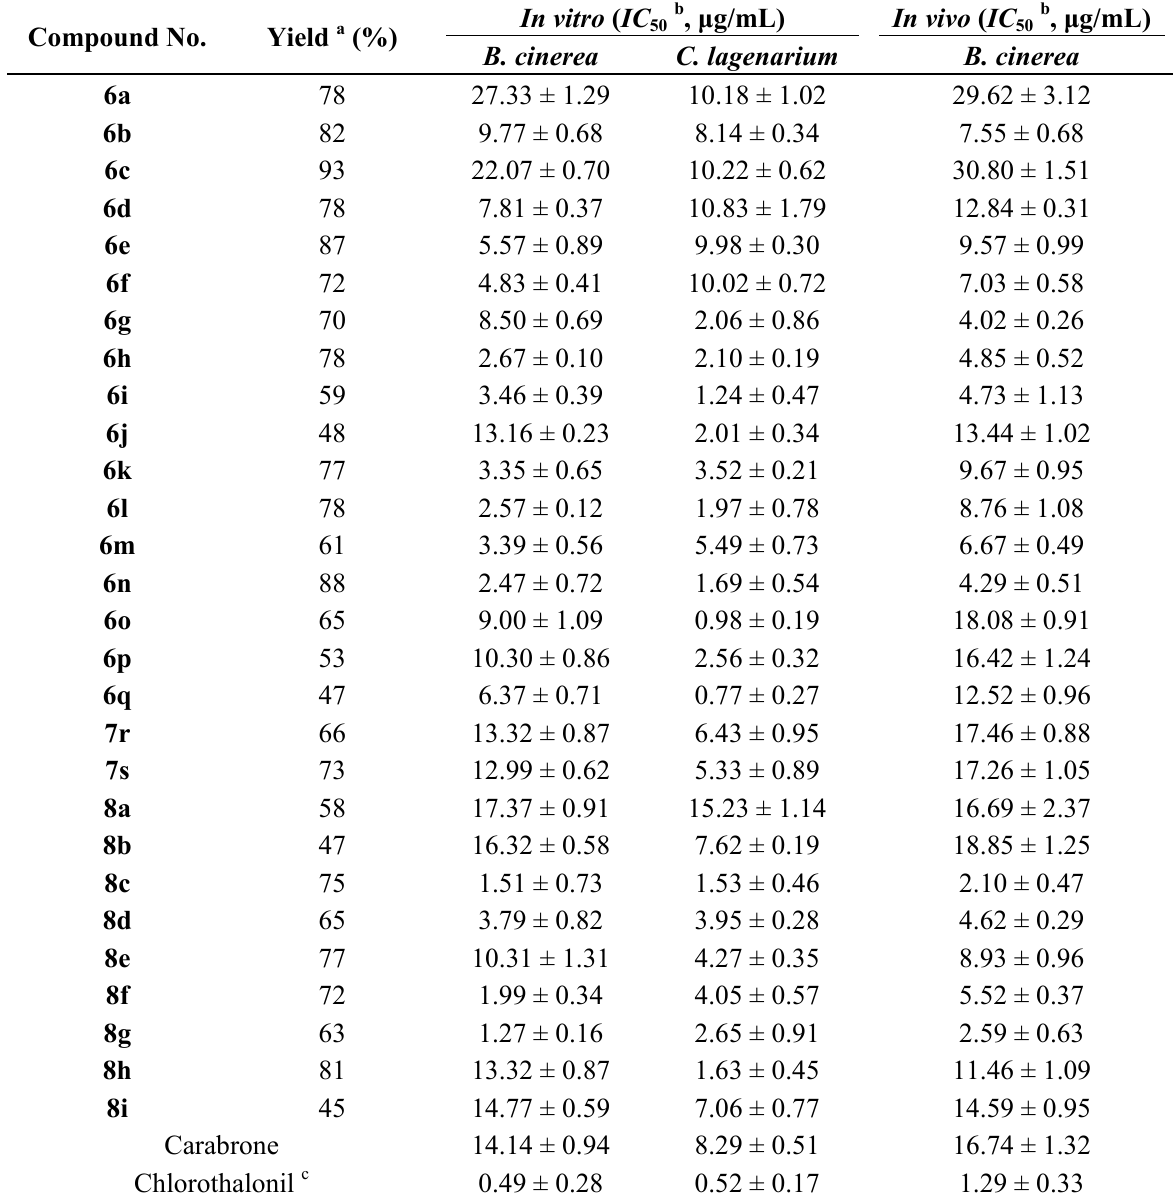
Table 1. Chemical yields and antifungal activities of the 28 hydrazone derivatives of carabrone. Compound